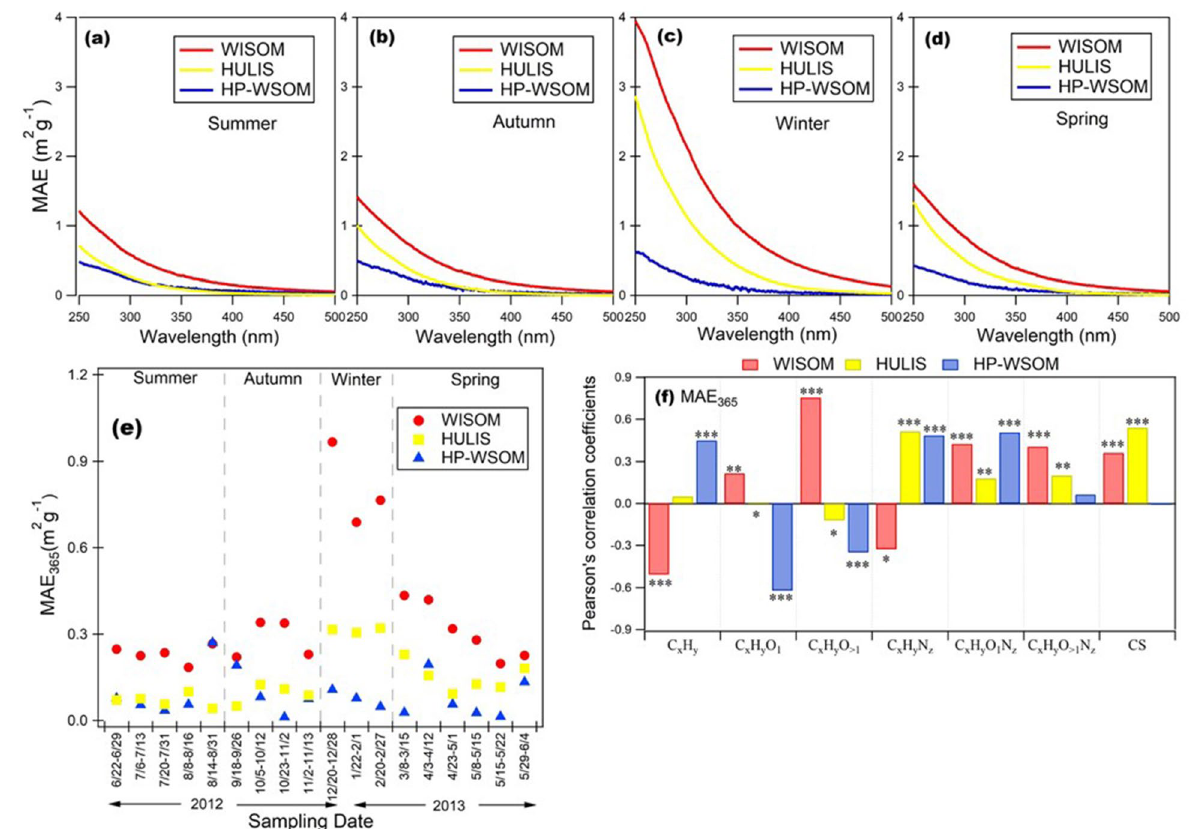
Figure 4. ( a–d ) Seasonal averages of the mass absorption efficiency (MAE) of the aerosol extracts, ( e ) temporal variations in MAE at 365 nm, and ( f ) Pearson’s correlation coefficients ( n = 18) and significance levels (*: < 0.05, **: < 0.01, ***: < 0.001) from the correlation analysis of the MAE 365 of WISOM, HULIS, and HP-WSOM and the relative intensities of HR-AMS-derived ion groups. The format of the sampling date is start month/date to end